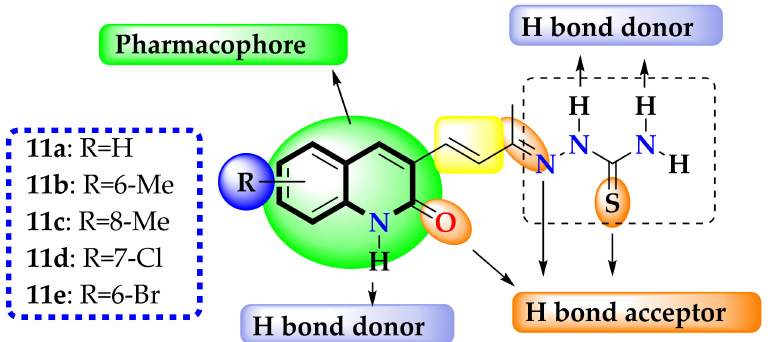
Figure 4. Pharmacophore and QSAR-based designed compounds in this